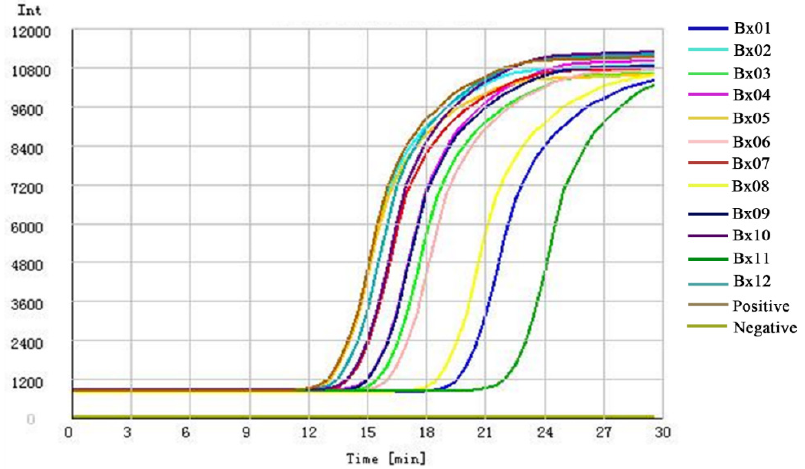
Figure 4. DNA amplification curve resulting from EMA of B. xylophilus PWNs from different geographical sources.